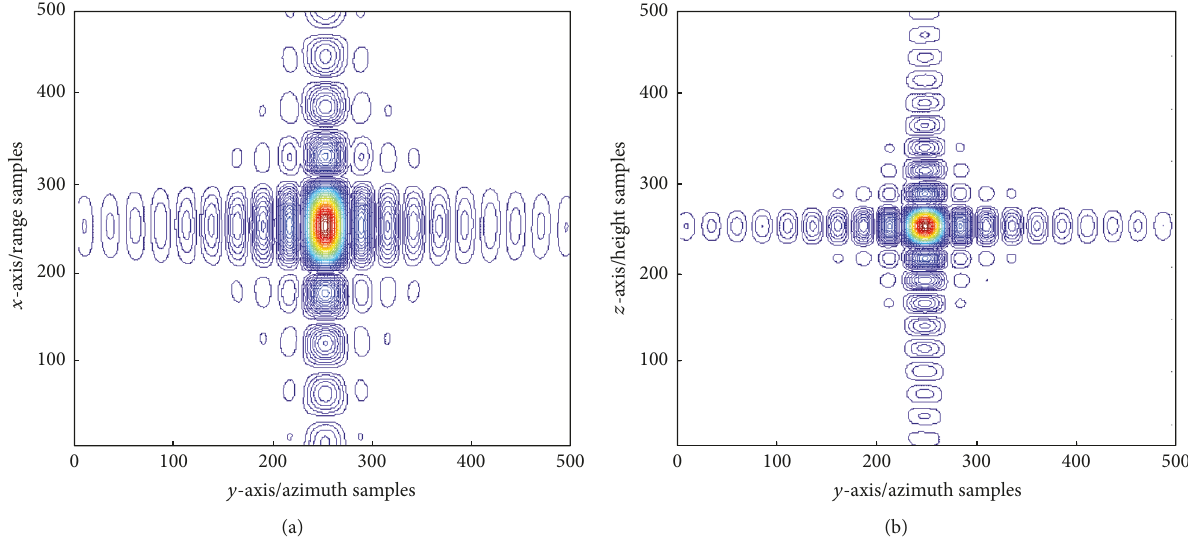
Figure 5: The impulse response on the (a) azimuth-range plane and (b) azimuth-height plane. The displayed dynamic range is 40